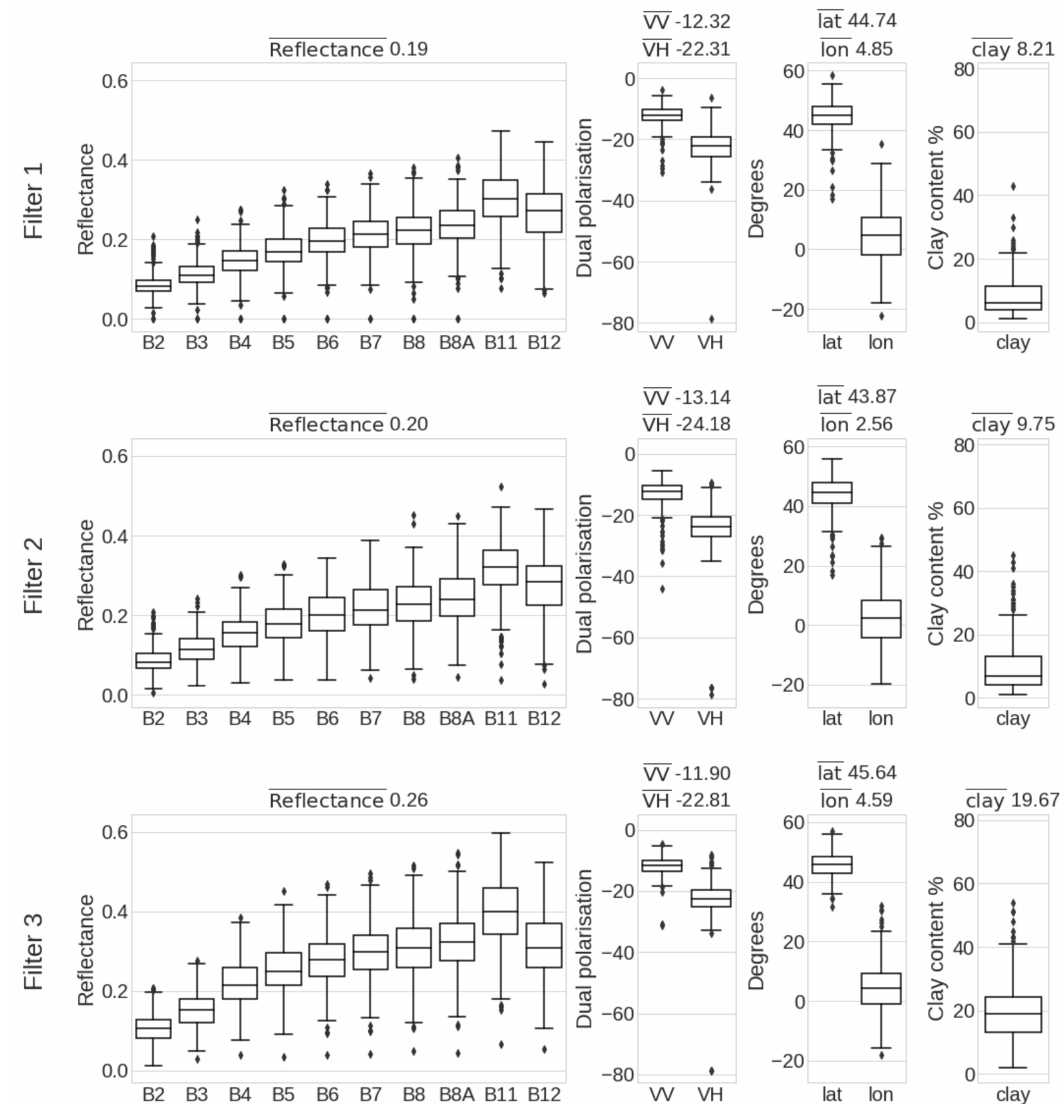
Figure 10. Visualization of the top 5% of activated patterns from the training set for the first three selected filters from the final convolutional layer. x is the arithmetic mean of x